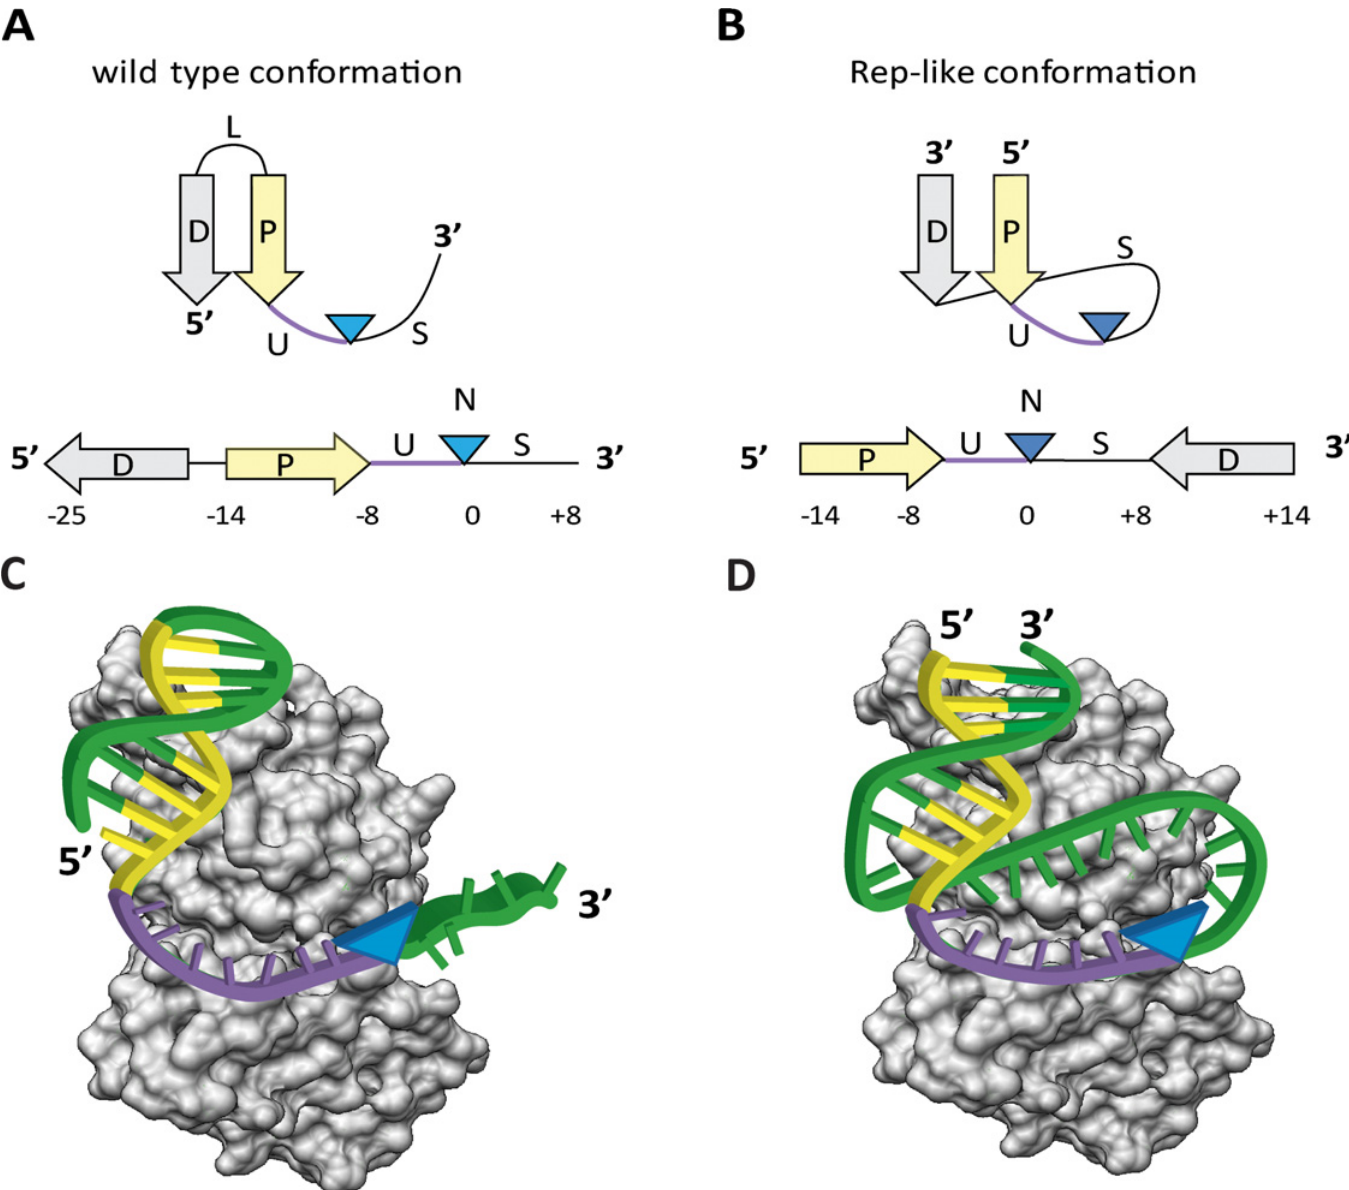
Fig 1. Scheme of relaxase and replicase DNA targets. (A) The relaxase DNA substrate contains an IR, defined by a Distal arm (D) and a Proximal Arm (P), that shape a hairpin structure. The nic site (N) is located between a U-turn (U) sequence and a ssDNA strand (S) that is tethered to the relaxase after cleavage. (B) The DNA substrate cleaved by replicases has the Distal arm (D) located downstream from nic (N), which allows stem-loop formation. Rep-like substrates for relaxases were designed by displacing the D sequence to the 3 ’ end of S of their original wt substrate. (C) Scheme depicting the cleavage reaction of the wt substrate. Upon binding, relaxase bends its target in order to localize the nic site (N) within its active center. In presence of a divalent cation, the relaxase cleaves nic (blue arrowhead) and remains covalently bound to the 5 ’ -phosphate of S, downstream from N. (D) Scheme depicting the cleavage reaction of the Rep-like substrate. The stem is bound by the relaxase, and the loop is located within the DNA binding cleft. Thus, the relaxase cleaves the scissile nucleotide within a stable cruciform (blue arrowhead). After cleavage the relaxase will be tethered to S and D. P is shown in yellow and U in purple. Blue triangles show the position of the nic